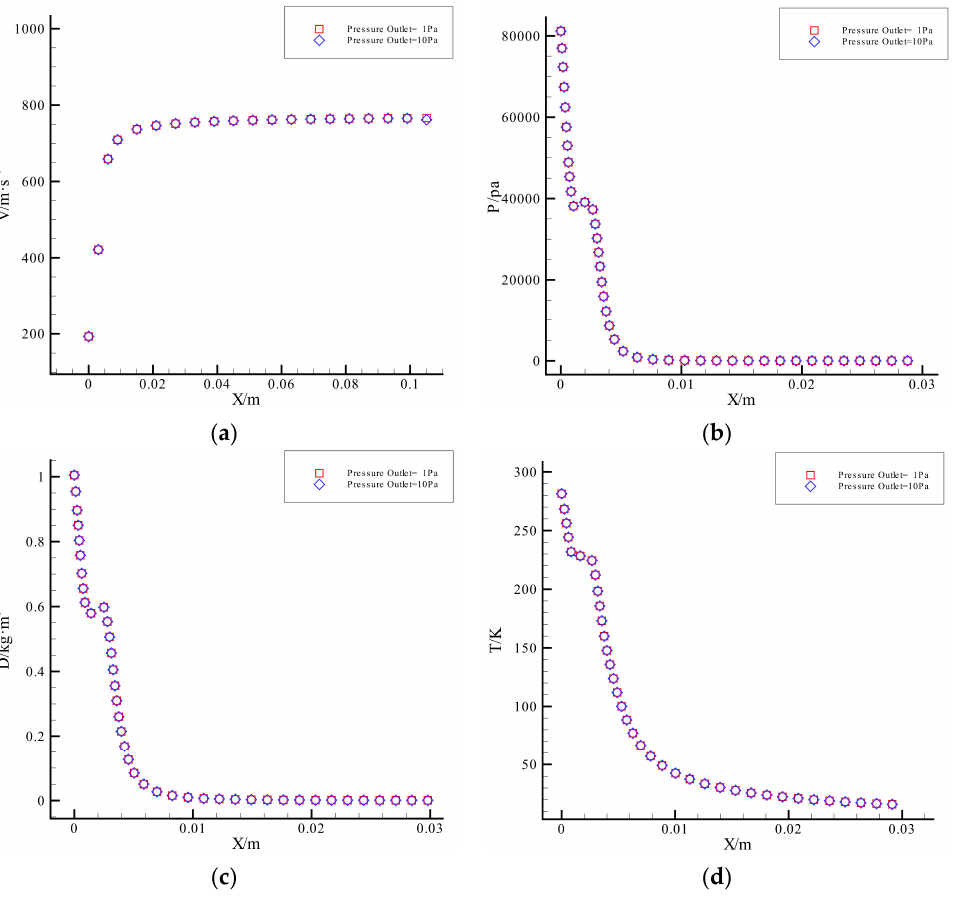
Figure 2. Comparison of axial aerodynamic properties under different back pressure. ( a ) velocity; ( b ) pressure; ( c ) density; ( d ) temperature.